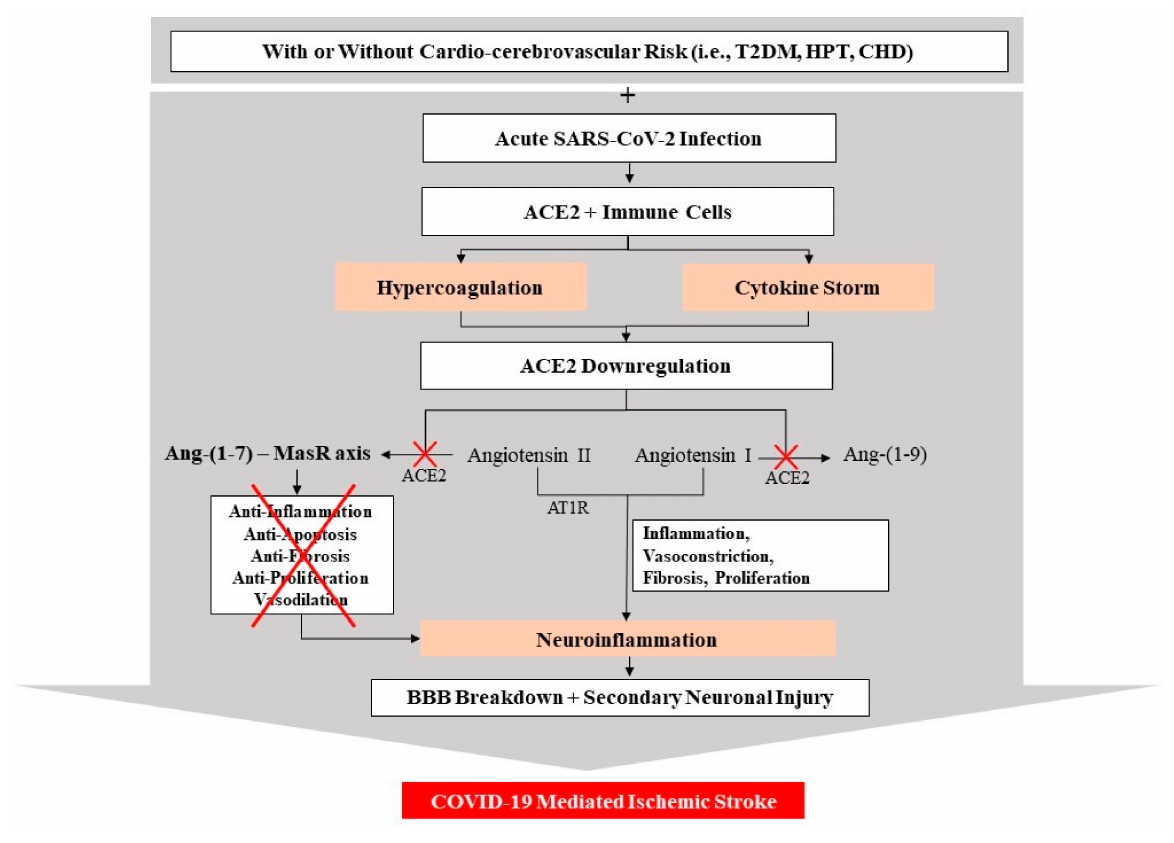
Figure 2. Possible mechanism of COVID-19-mediated ischemic stroke due to SARS-CoV-2-infection- mediated downregulation of angiotensin-converting enzyme 2 (ACE2) from renin angiotensin system (RAS). Reduced expression of ACE2 inhibits the conversion of angiotensin II to Ang-(1-7) and of angiotensin 1 to Ang-(1-9). Reduced Ang-(1-7) activity and its axis with mitochondrial assembly receptor (MasR) interfere with the anti-inflammatory, anti-apoptosis, anti-fibrosis, and vasodilation effect, thereby increasing blood–brain barrier (BBB) permeability and damage. Furthermore, the overactivation of angiotensin II binds to its angiotensin II type 1 receptor (AT1R), promoting further inflammation, vasoconstriction, fibrosis, and proliferation, thereby increasing secondary (2 ◦ ) neuro- glial cell injury, leading to neuroinflammation and, finally, brain ischemia. CHD, coronary heart disease; HPT, hypertension; T2DM, type 2 diabetes